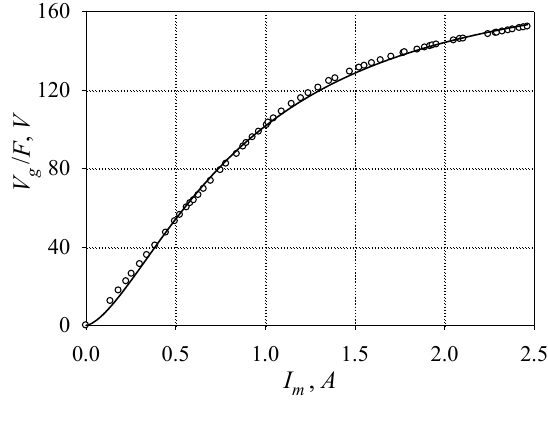
Figure A1. Magnetizing curve of the